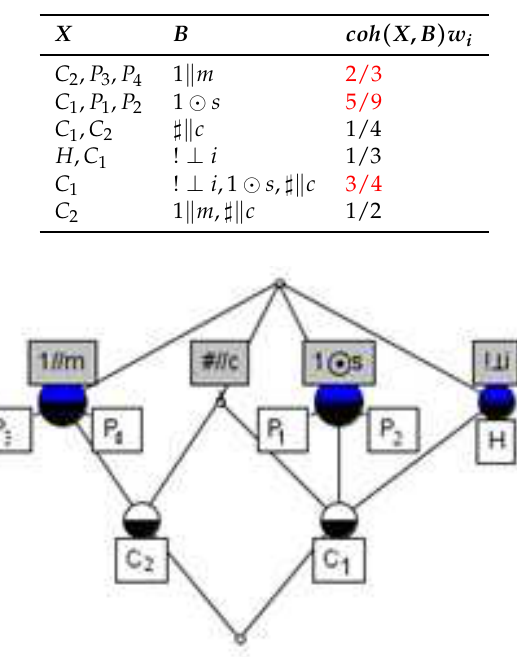
Table 10. The Coh value of a fork.